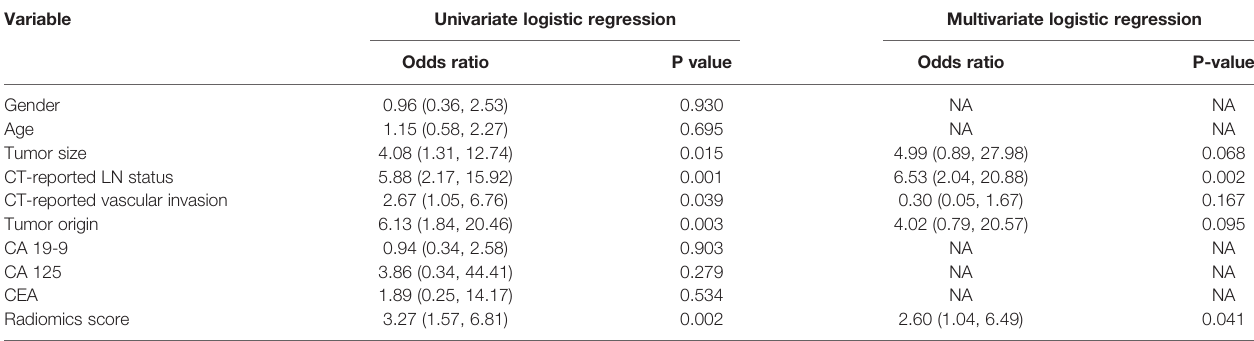
TABLE 3 | Risk factors for LN metastasis in periampullary carcinomas. Variable Univariate logistic